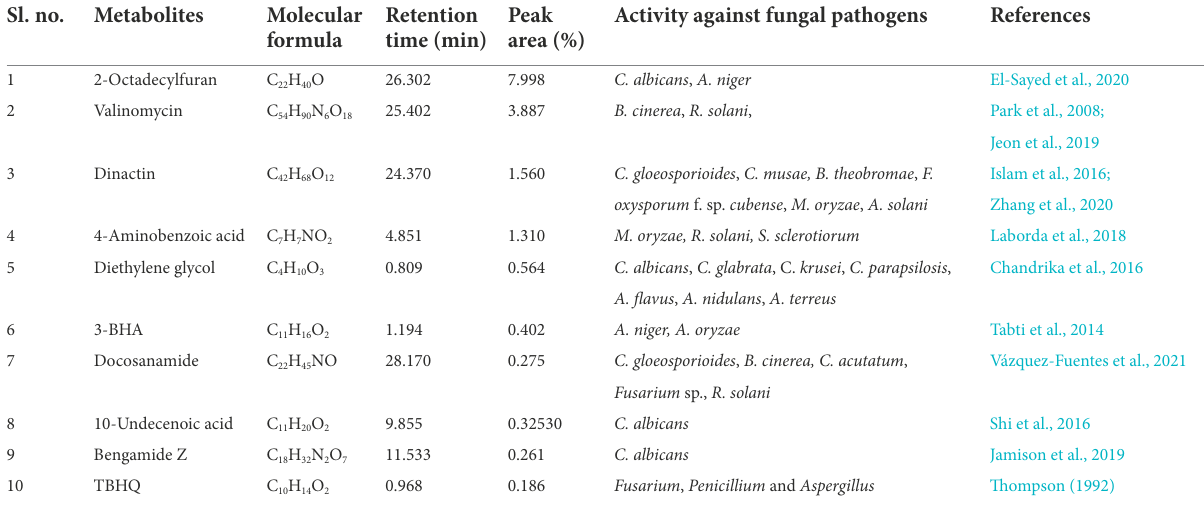
TABLE 4 List of some bioactive molecules with reported antifungal activity identified through LC–MS analyses of ethyl acetate extracts of Streptomyces araujoniae (TN19). Sl.